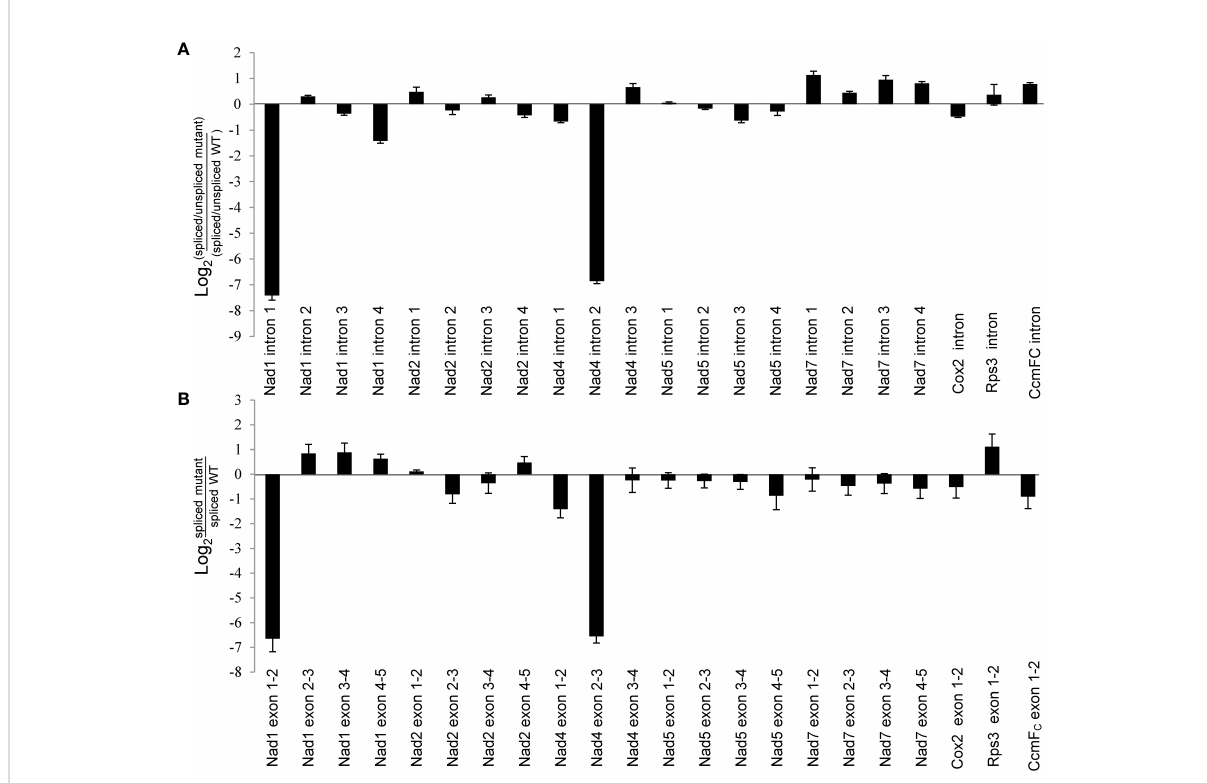
FIGURE 6 Splicing de fi ciency of Nad1 intron 1 and Nad4 intron 2 in 10 DAP zmnmat1 kernels. (A) qRT-PCR analysis of intron splicing de fi ciency of mitochondrial genes. Primers spanned adjacent exons and introns were used to measure the differences in splicing ef fi ciency. Data was shown as the average ± S.E. of three biological replicates. (B) qRT-PCR analysis of mature mitochondrial transcripts. Primers spanning adjacent exons were used for measuring differences in each spliced fragment. ZmActin was used as an internal control. Data was shown as the average ± S.E. of three biological